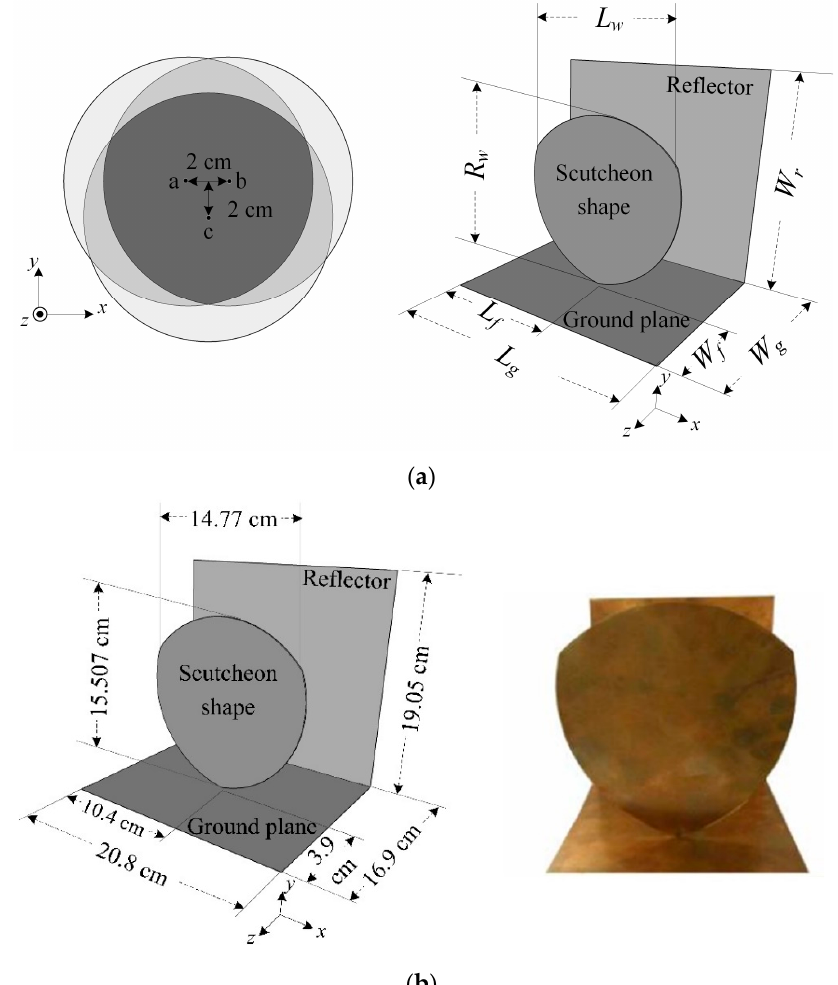
Figure 3. The scutcheon antenna: ( a ) geometry and parameters; ( b ) dimensions and photograph.